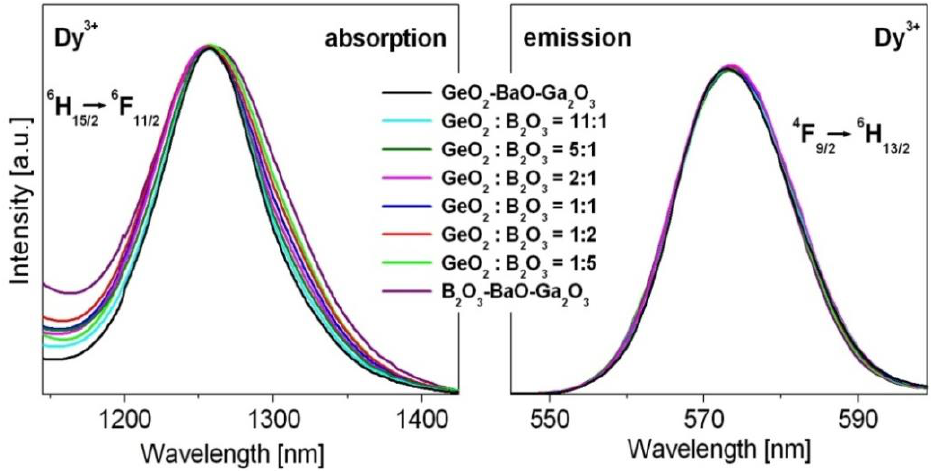
Figure 6. Hypersensitive absorption and emission transitions Dy 3+ ions.